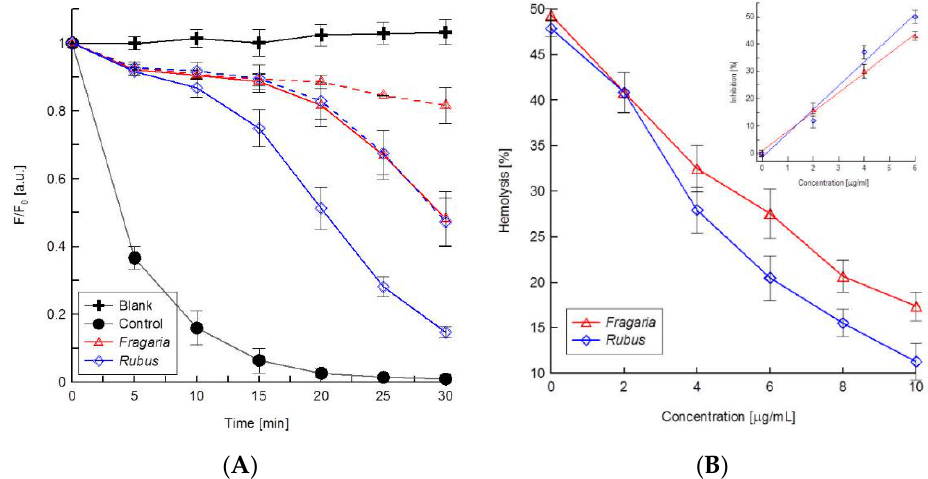
Figure 6. Antioxidant activity of the extracts to ( A ) erythrocyte membrane — relative fluorescence intensity of TMA-DPH probe vs. time of membrane oxidation. Rubus and Fragaria extracts were used at concentrations 4 (solid line) and 8 µg/mL (dashed line) and 3 (solid line) and 4 µg/mL (dashed lines), respectively. ( B ) erythrocytes — percentage of haemolysis of cells after 3 h oxidation by AAPH at 40 µM vs. concentration of the extracts. The dependence of the inhibition (%) of erythrocyte oxidation on the concentration of tested extracts is shown as the inserted figure. Table 2. IC 50 concentrations of Rubus and Fragaria leaf extracts that inhibit oxidative damage of erythrocyte membrane lipids (RBC membrane), erythrocytes (RBC) and human vascular endothelial cells